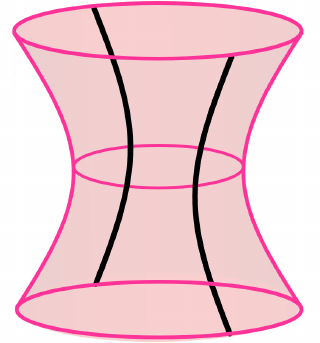
Figure 3 . Illustration of the bulk braneworld from the AdS 4 C-metric. The brane is placed at x = 0 (magenta hyperboloid surface). The black lines denote r = 0 and depict the worldlines of the accelerating black holes described by the C-metric. The AdS interior of the hyperboloid is kept, and the double-sided brane is glued to another copy of